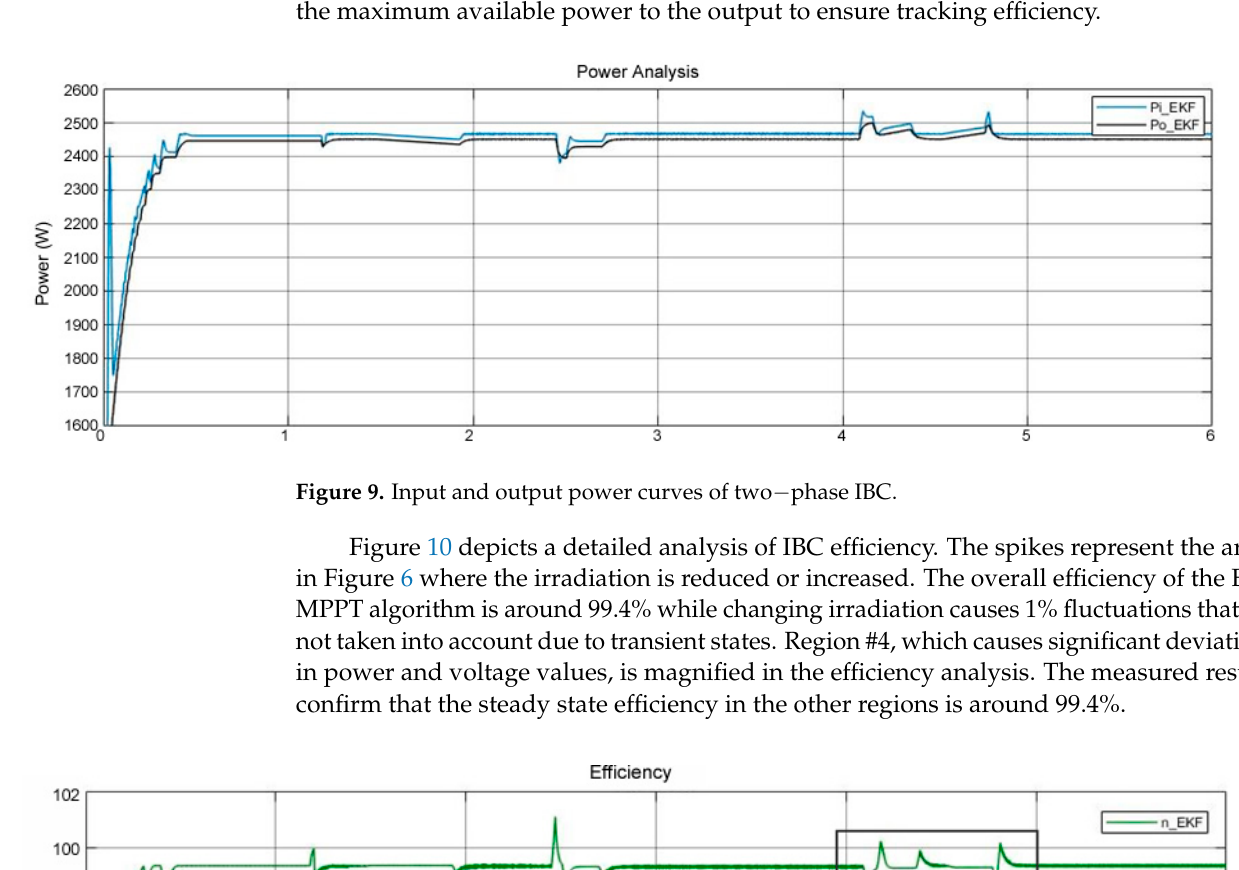
Figure 10. Efficiency analysis of two − phase IBC.